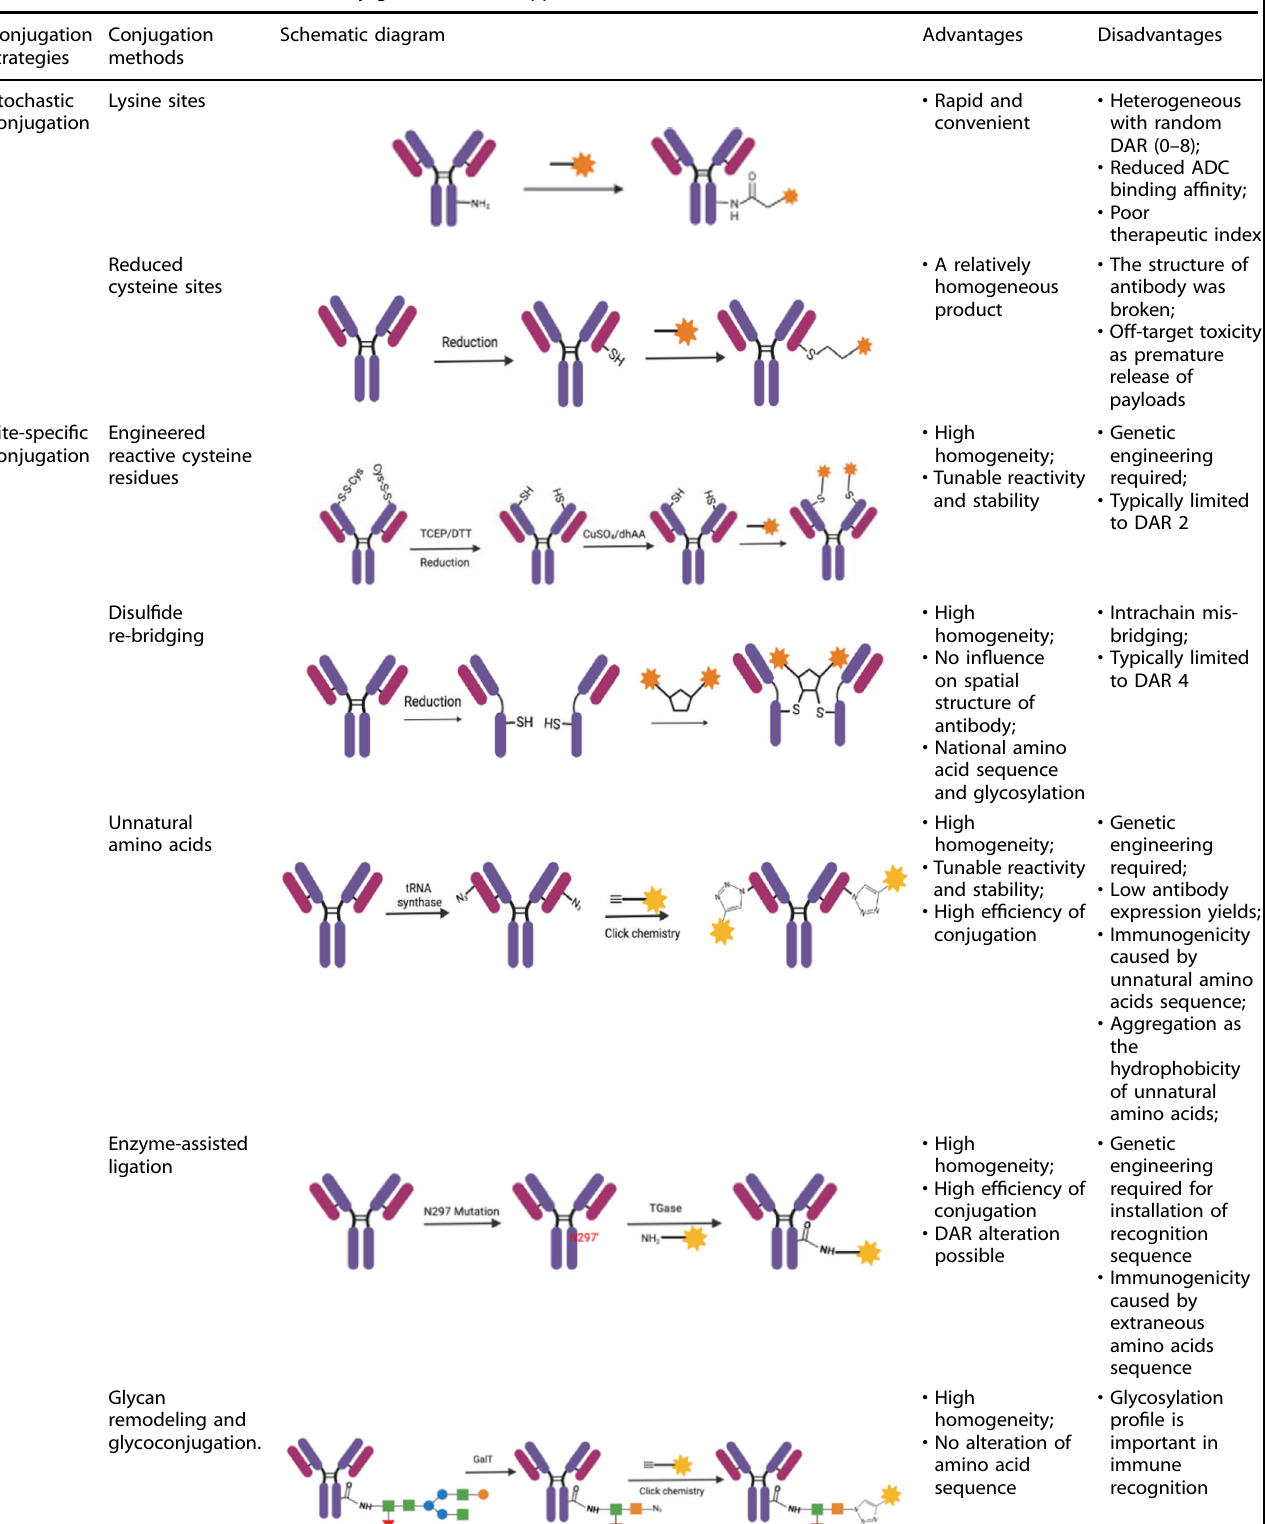
Table 2. The characteristics of various conjugation methods applied for